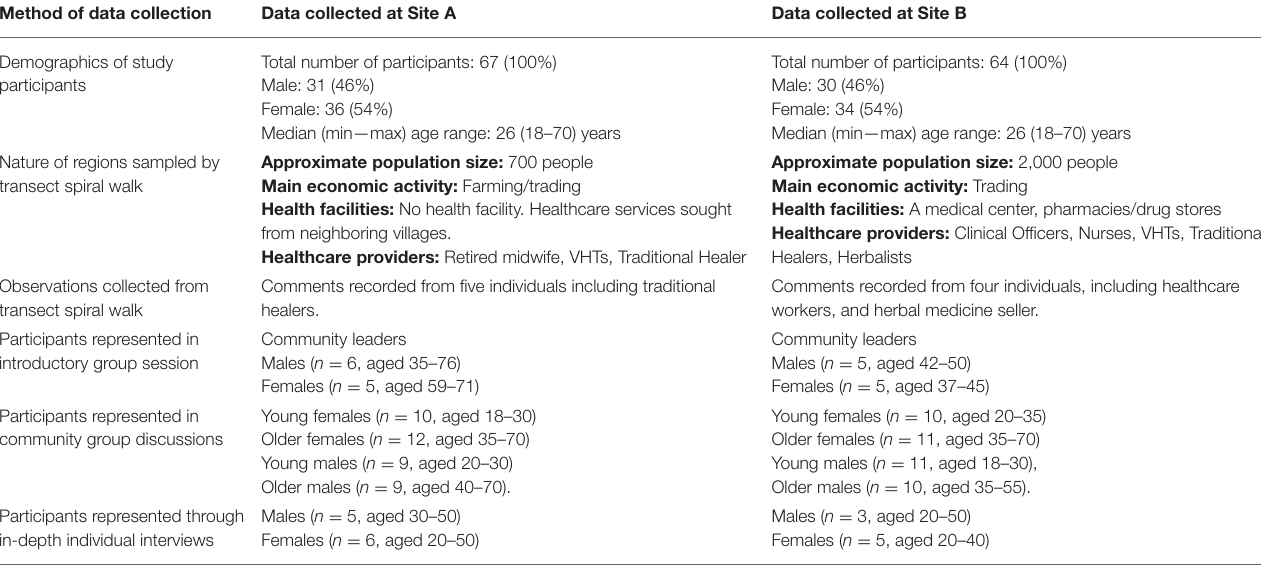
TABLE 1 | Description of study areas and characteristics of study participants. Method of data